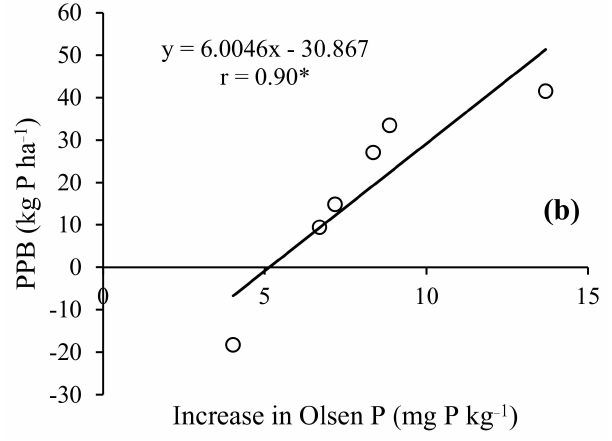
Figure 6. The correlation between partial P balance with ( a ) increase in soil total P and ( b ) increase in Olsen P, of all treatments. *, significant at p <